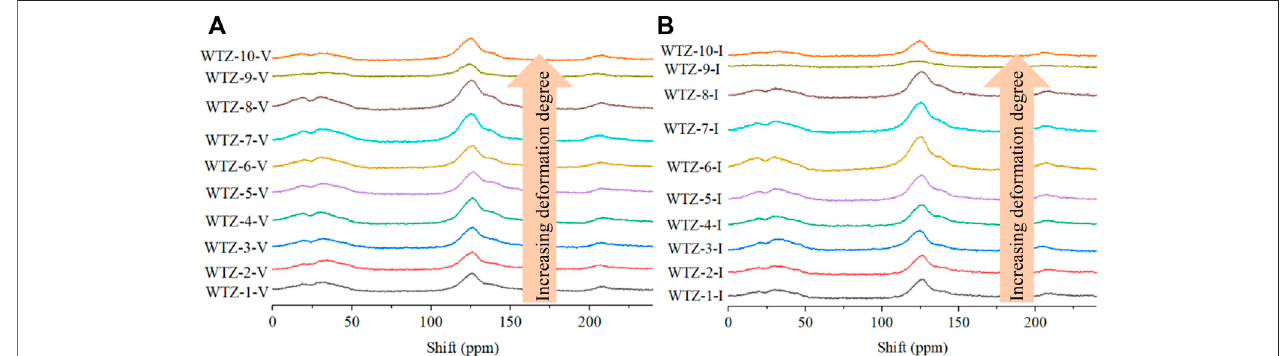
FIGURE 3 | NMR spectra of vitrinite (A) and inertinite (B) .